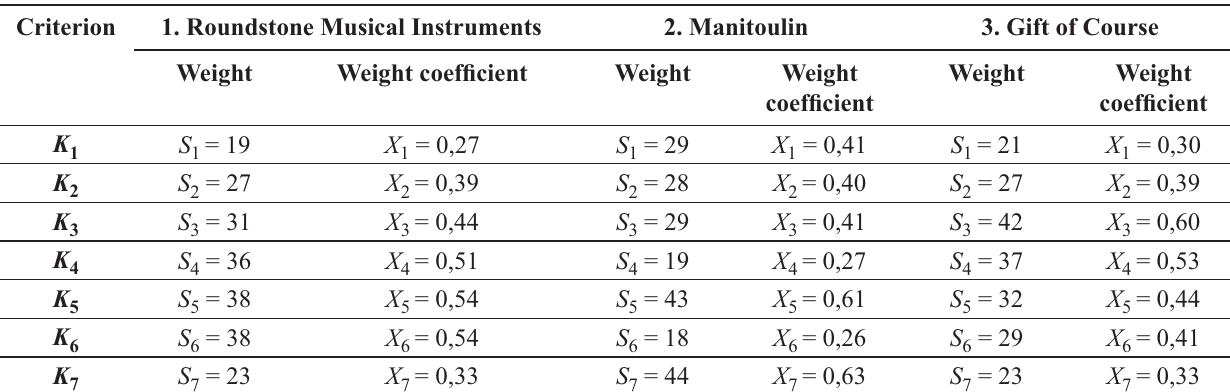
Table 3. Comparison of alternative projects